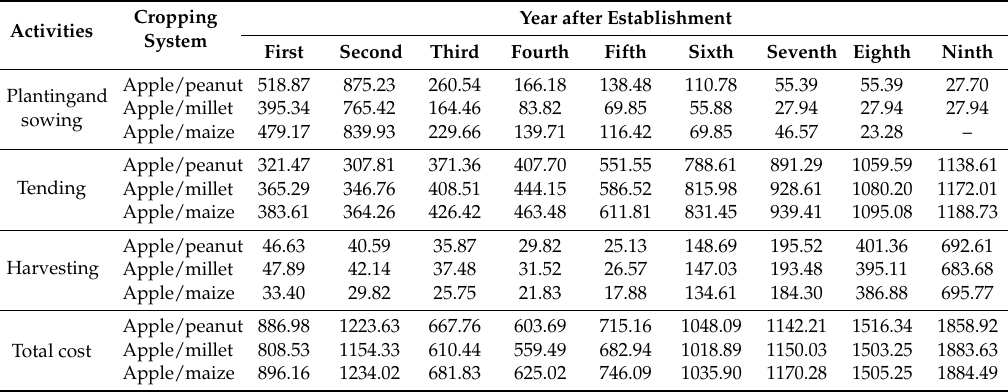
Table 6. Cost structure (USD ha − 1 ) of apple/crop alley cropping systems in